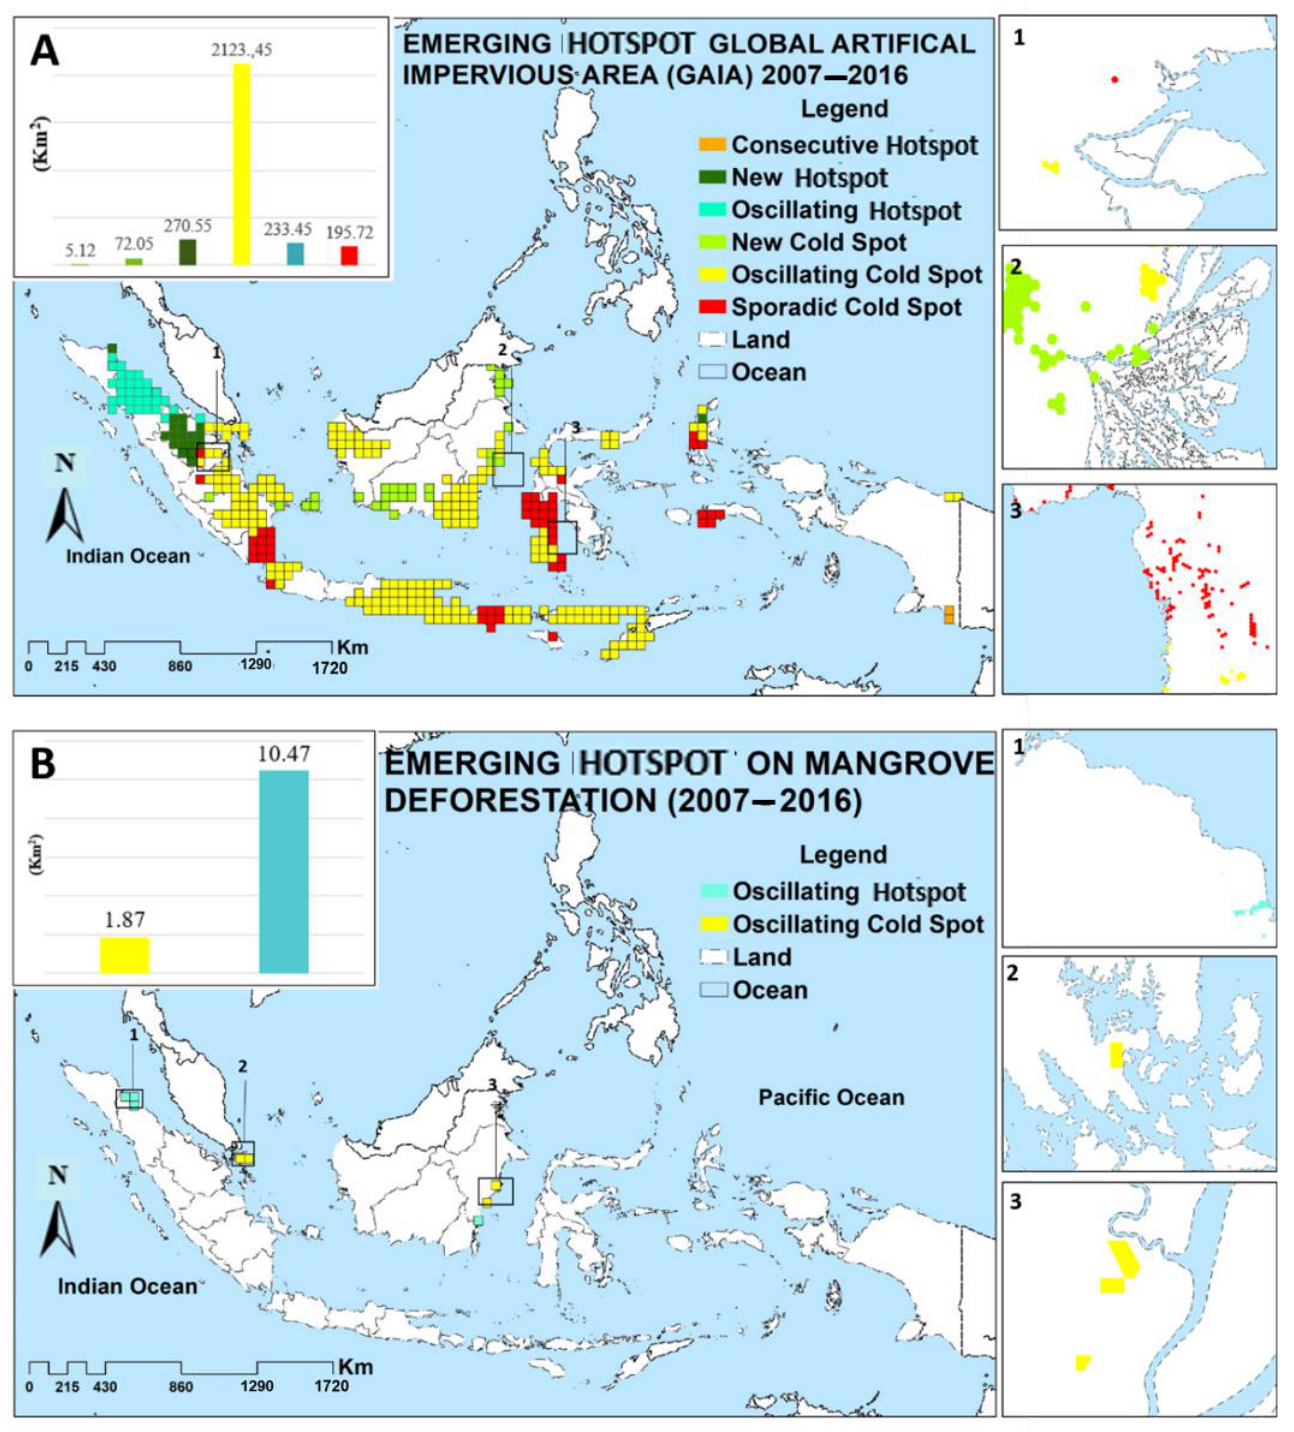
Figure 12. Classification of urban growth based on the GAIA data and hotspot analysis for 2007–2016 with a grid visualization of 1 km. ( A ) Trends in urban growth in all regions of Indonesia; ( B ) trends of urban growth in deforested mangrove areas.